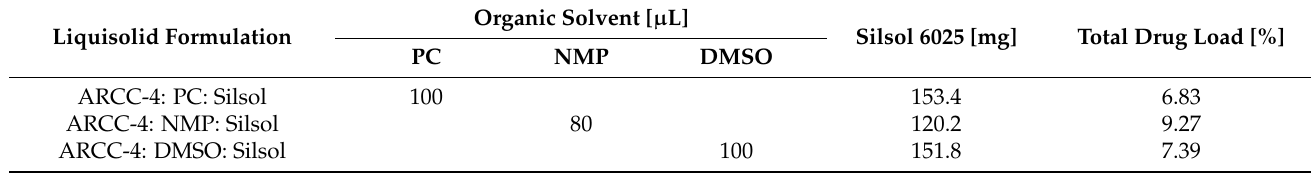
Table 2. Composition of the liquisolid